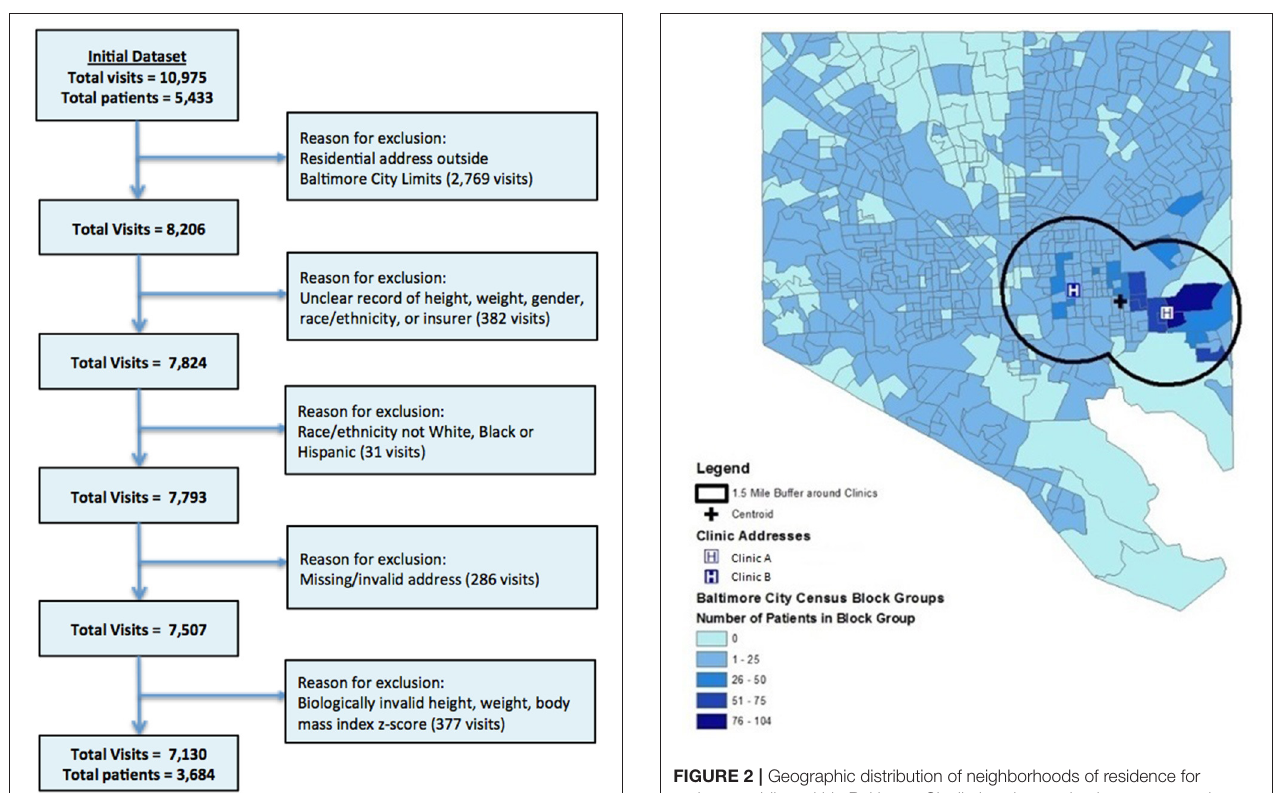
FIGURE 2 | Geographic distribution of neighborhoods of residence for patients residing within Baltimore City limits who received care at two urban, hospital-affiliated primary care clinics. Neighborhoods are depicted as census block groups, and 1.5-mile buffer around each clinic and point location of each clinic are